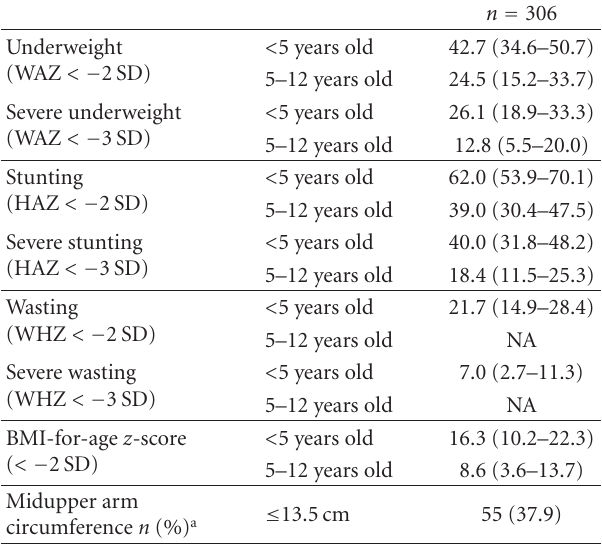
Table 3: Nutritional status of the “Monitoring of Antiretroviral Therapy in Children” cohort participants at